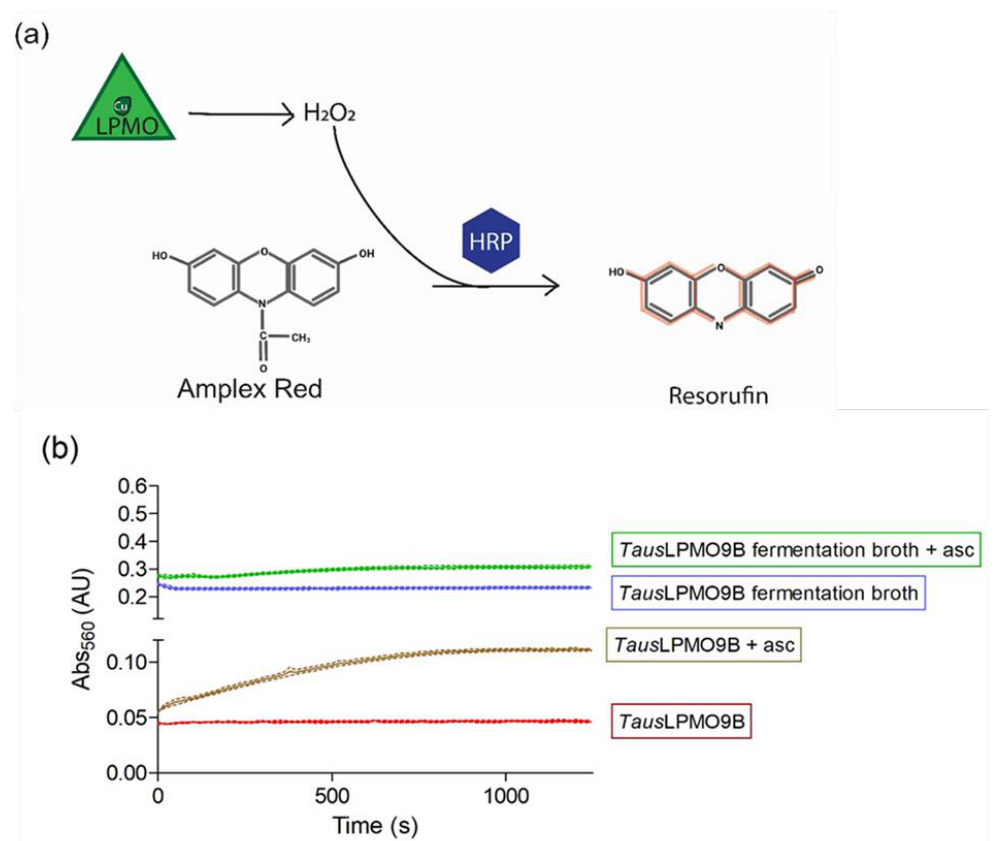
Figure 7. Amplex TM Red assay used to detect LPMO activity. ( a ) Horseradish peroxidase (HRP) utilizes the H 2 O 2 generated by LPMOs to convert Amplex TM Red to resorufin, a fluorescent molecule with excitation and emission maxima at 571 and 585, respectively. ( b ) Taus LPMO9B activity tested with the Amplex TM Red assay before (green and blue lines) and after (brown and red lines) enzyme purification. Reactions were run in 50 mM sodium phosphate buffer pH 7 and contained 5 U/mL of HRP, 100 µ M Amplex TM Red, and 20 µ L of purified Taus LPMO [47] or diluted fermentation broth (1:4) in a final volume of 100 µ L. Reactions were started by the addition of ascorbic acid (brown and green lines) to a final concentration of 50 µ M. Reactions were run in triplicate; the dotted lines represent the standard deviation of 3 independent replicates. Various dilutions were tested for the fermentation broth, but the background absorbance was always too high to allow for the clear detection of LPMO activity. The LPMO content of fermentation broth was measured by the quantification of the protein band after SDS-PAGE electrophoresis. The intensity of the band was measured and compared to a BSA standard curve by digital imaging using ImageJ (Image Processing and Analysis in Java; available at http://imagej.nih.gov/ij/, accessed on 5 January 2021). Samples were diluted to fit in the linear quantifiable range (0.050–0.250 mg/mL protein). The LPMO content of the fermentation broth was estimated to be 0.1